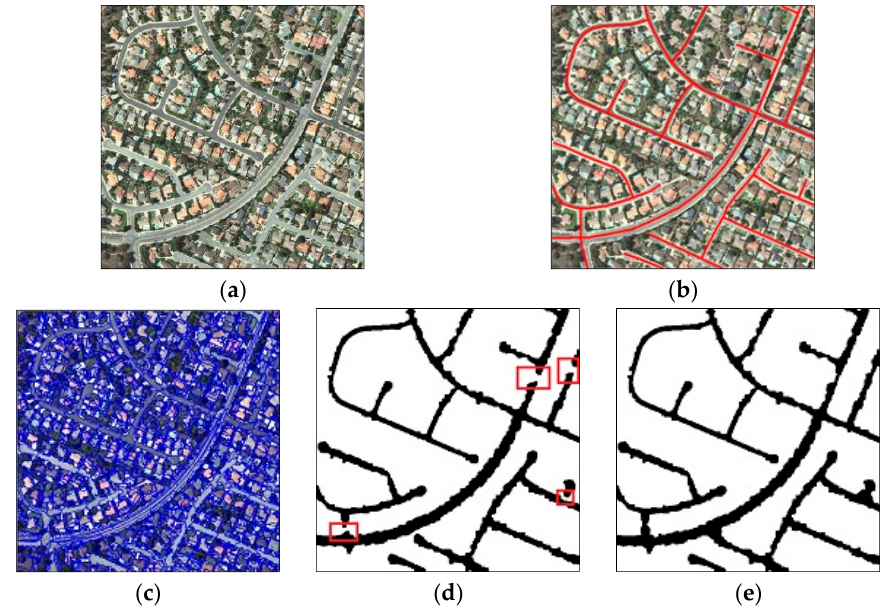
Figure 5. First study area: ( a ) input image; ( b ) ground truth data obtained via manual digitization; ( c ) segmentation result; ( d ) road binary map; ( e ) filling gaps using CTV.